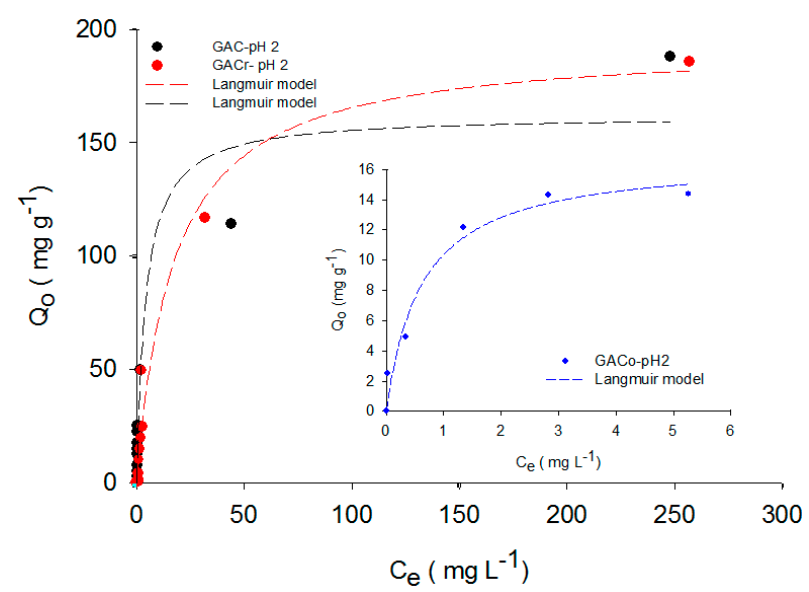
Figure 4. Paracetamol adsorption isotherm on GAC, GACo and GACr at pH 2 and T = 298 K.